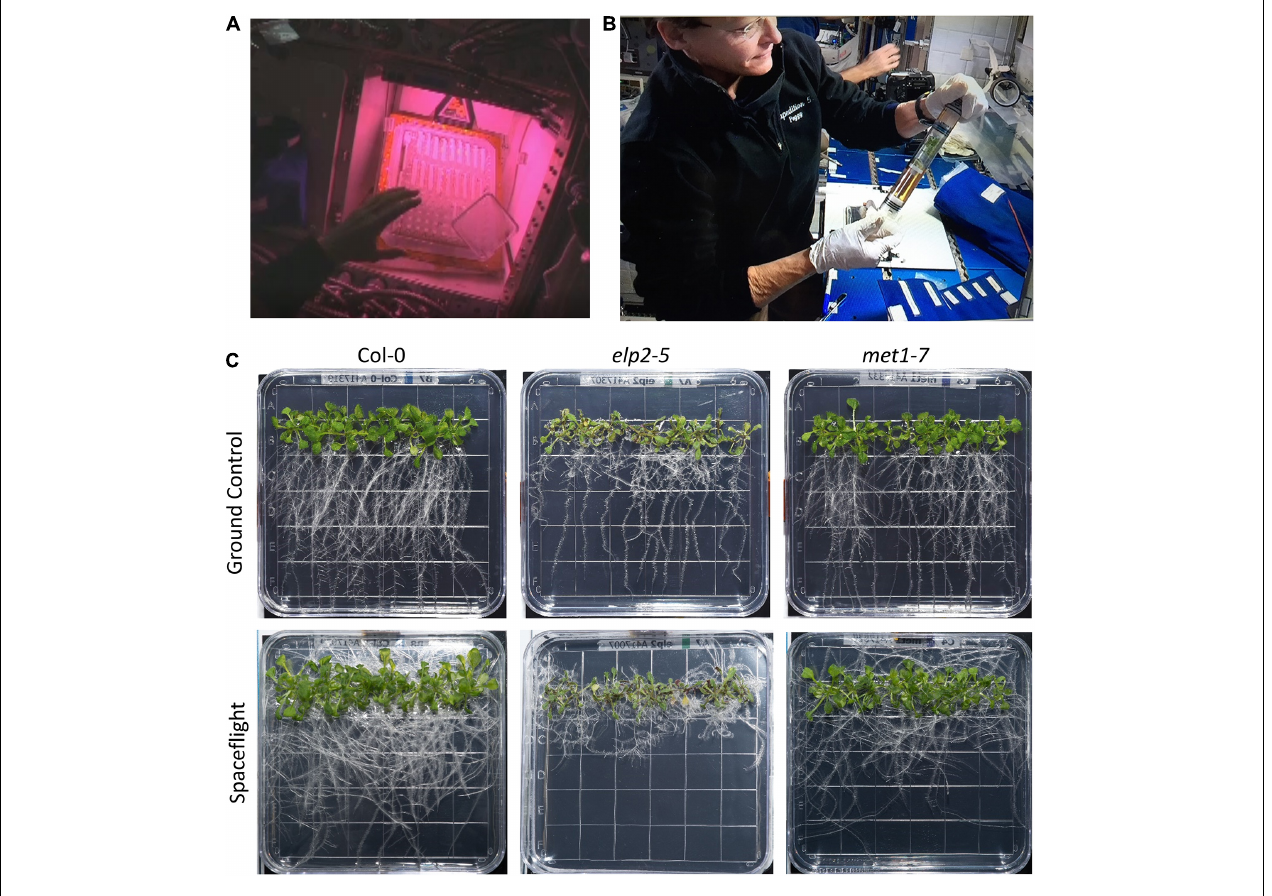
FIGURE 1 | On orbit operations and comparison of plant growth in both environmental conditions. (A) Astronaut Peggy Whitson inserts seeded plates into the Veggie growth hardware on the ISS. The pinkish lighting is derived from the mixture of red and blue LED growth lights (also Supplementary File 1 ). (B) Peggy Whitson harvests the 11 day old seedlings to RNAlater-filled KFTs at the MWA on the ISS. (C) Representative examples of each of the three genotypes (Col-0 wild-type, elp2 , and met1-7 ) grown for 11 days in the Veggie hardware in the ISS Environment simulation chamber (ISSES) for the ground controls (top row) and grown for 11 days in Veggie on the ISS for the spaceflight environment (bottom row; also Supplementary File 3 ).